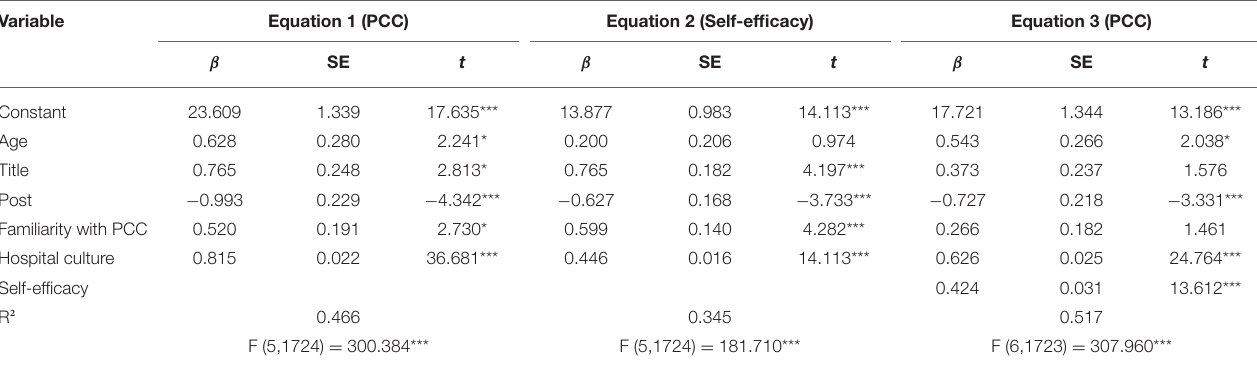
TABLE 4 | Testing the mediation model of